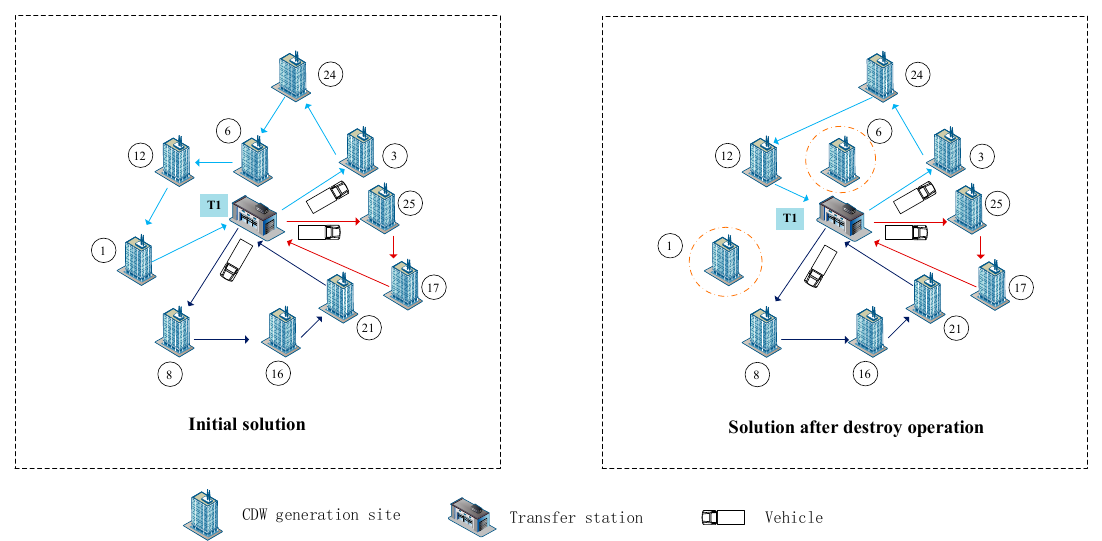
Figure 4. The process of the destroy operation.